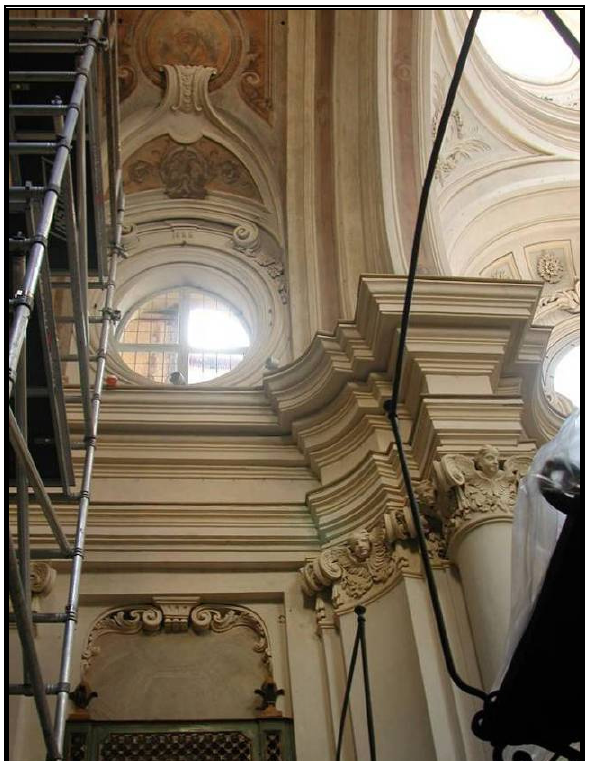
Figure 3 – Eidotype and architectonic survey